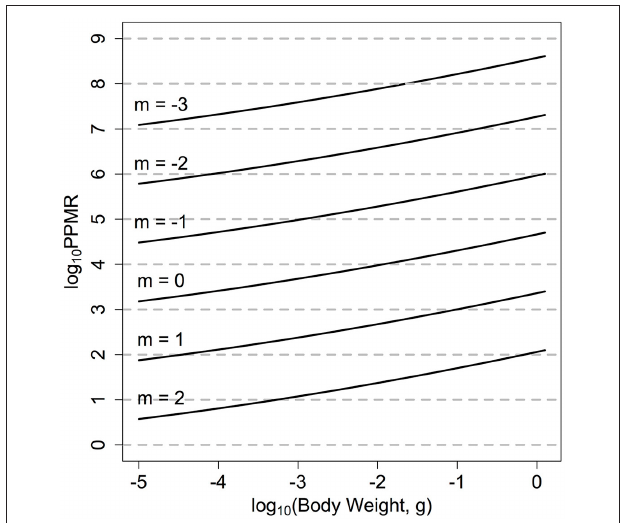
FIGURE 2 | log 10 PPMR for the range of quantitative feeding modes from carnivores to herbivores. Wirtz (2012), across the zooplankton size classes. The solid lines indicate the realized log 10 PPMR for different feeding modes, across the size range of the zooplankton